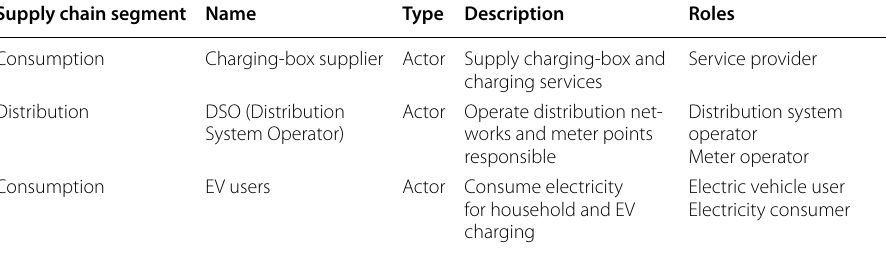
Table 20 The critical actors and objects related to the EV home charging energy